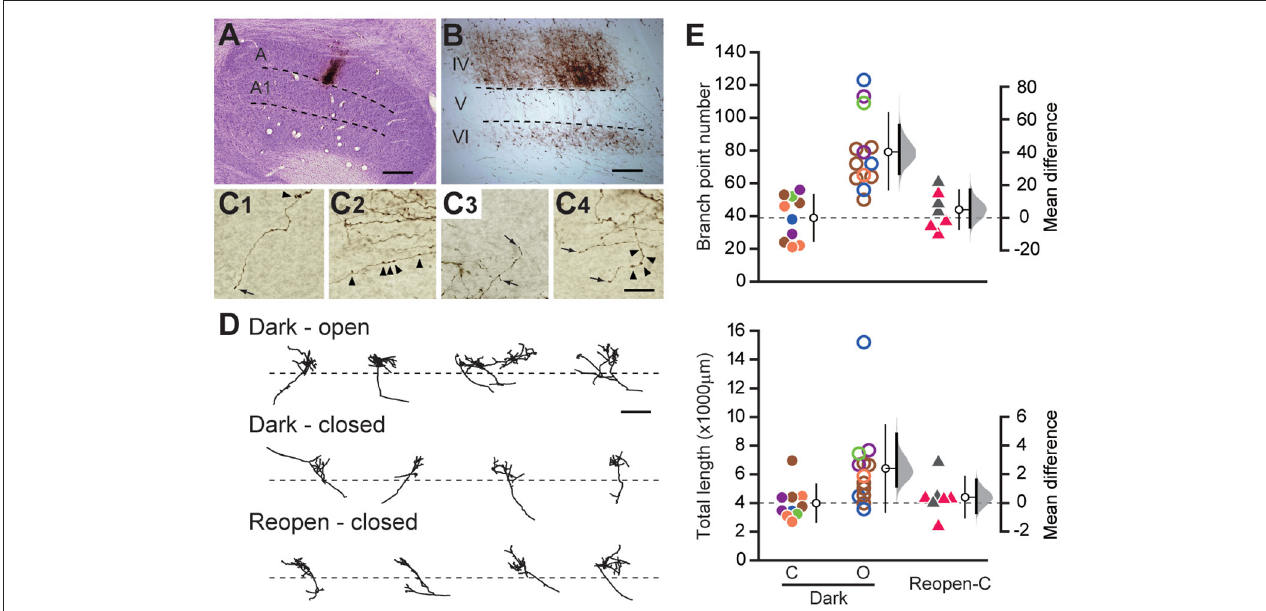
FIGURE 2 | Geniculocortical axons serving the closed eye remain retracted after dark rearing. (A) Example of a Nissl-stained coronal section of the lateral geniculate nucleus containing a BDA injection site in layer A. Scale: 500 µ m. (B) Low magnification view of the labeled geniculocortical axons in the primary visual cortex. Dense arborization is observed in layer IV. Scale: 200 µ m. (C1–C4) High magnification view of the labeled axons in the visual cortex. The arrows and arrowheads indicate the terminal swellings and varicosities of axons, respectively. Scale: 20 µ m. (D) Drawings of reconstructed axons serving the open eye (top) and the closed eye (middle) of the Dark group, and those serving the closed eye in the Reopen group (bottom). The dotted lines indicate the border between layer IV and V. Scale: 500 µ m. (E) Comparison of axonal arbor morphology among animal groups. Each symbol represents the number of branch points (top) and the total length (bottom) of individual axons. The symbols with the same color represent data obtained from the same animal. The other conventions are the same as in Figure 1C . O, open-eye axon; C, closed-eye axon.